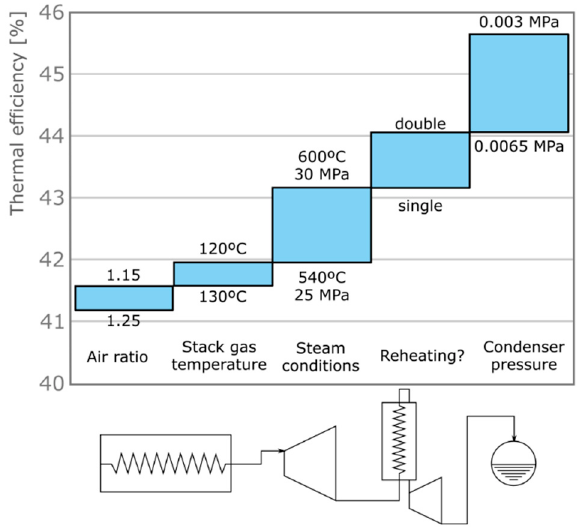
Figure 17. Impact of operating conditions and cycle modifications to improve thermal efficiency (adapted from [29]).